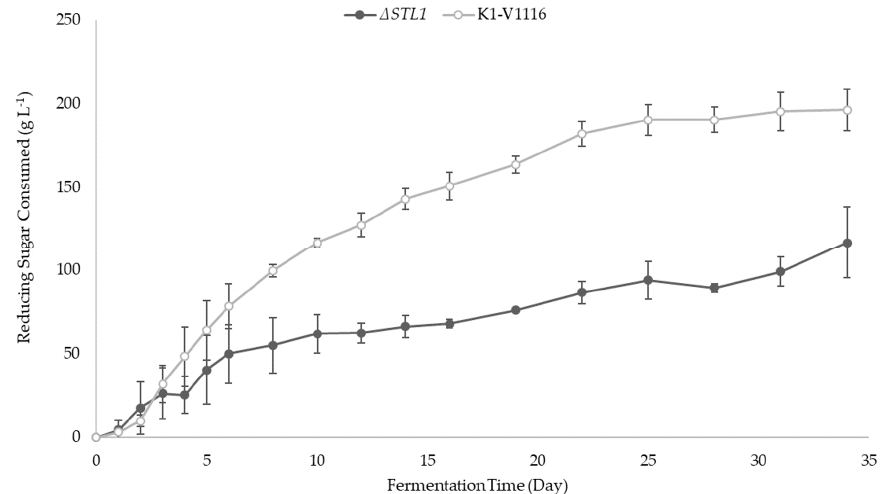
Figure 6. Reducing sugar consumed during fermentation. Fermentations of K1-V1116 ∆ STL1 ( ● ) and K1-V1116 ( ○ ) were performed in triplicate, with samples from each trial being analyzed in duplicate. Sugar values represent the average ± standard deviation.